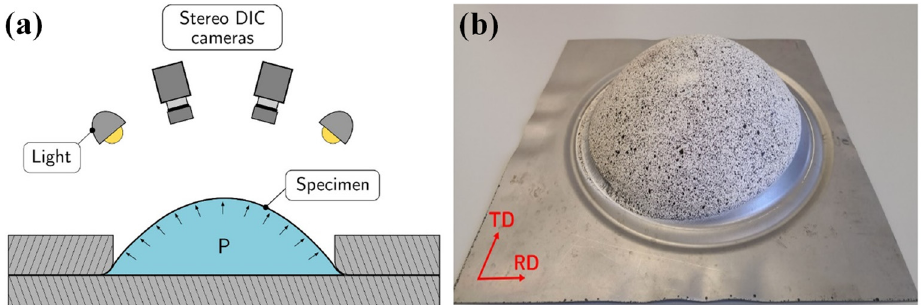
Figure 18. Hydraulic bulge test: ( a ) schematic of the experimental apparatus with DIC and ( b ) formed bulge specimen with DIC speckle pattern. Reprinted from Ref. [273], open access.